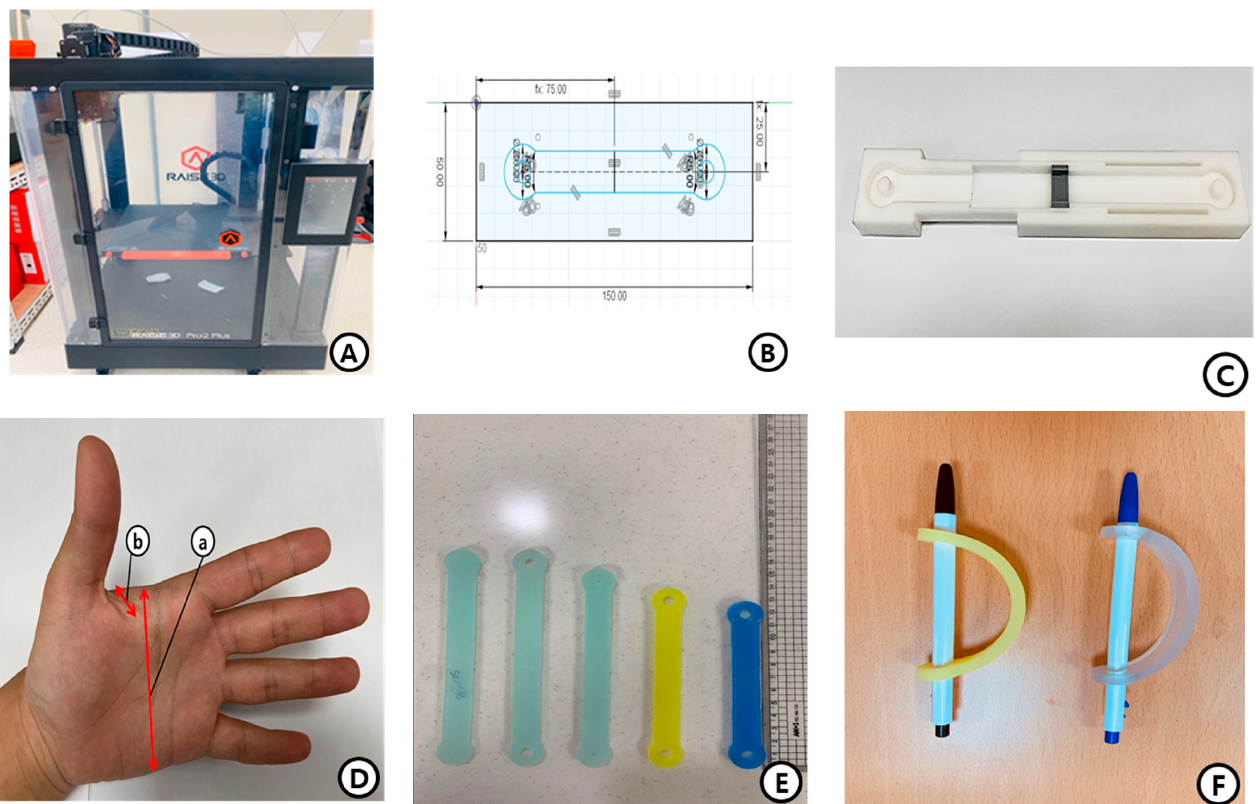
Figure 2. ( A ) Three-dimensional printer (RAISE3D Pro2 Plus; Tesla, Irvine, CA, USA). ( B ) Frame design on the STL file. ( C ) Three-dimensional-printed polylactic acid frame using the fused deposition modeling method. ( D ) a. Handbreadth from the MCP joint of the thumb to the MCP joint of the 2nd finger along the surface of the hand. b. Width between the index and little finger. ( E ) Five silicon assistive devices according to length. ( F ) Printing typing and writing integration device.